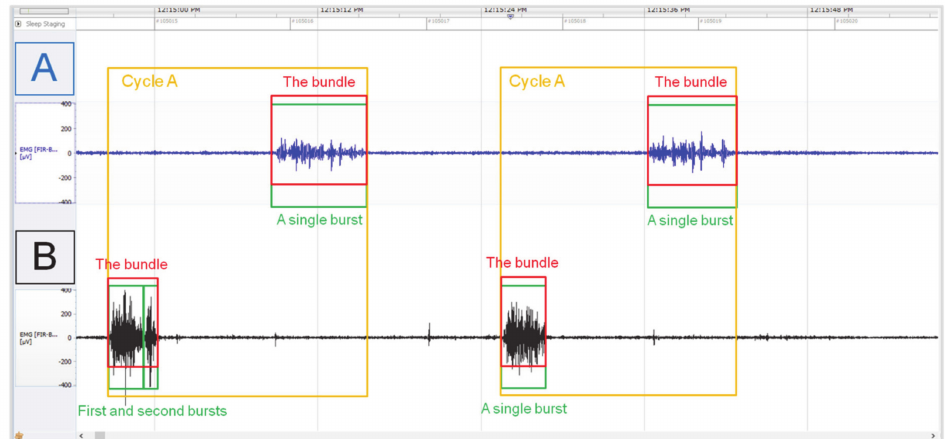
Figure 1. The representative images of the EMG signal recording in the reticulo − rumen, representing cycle A. Myoelectrical activity of the rumen ( A ); myoelectrical activity of the reticulum ( B ). NeuroScore analysis software, 1-min timeline.